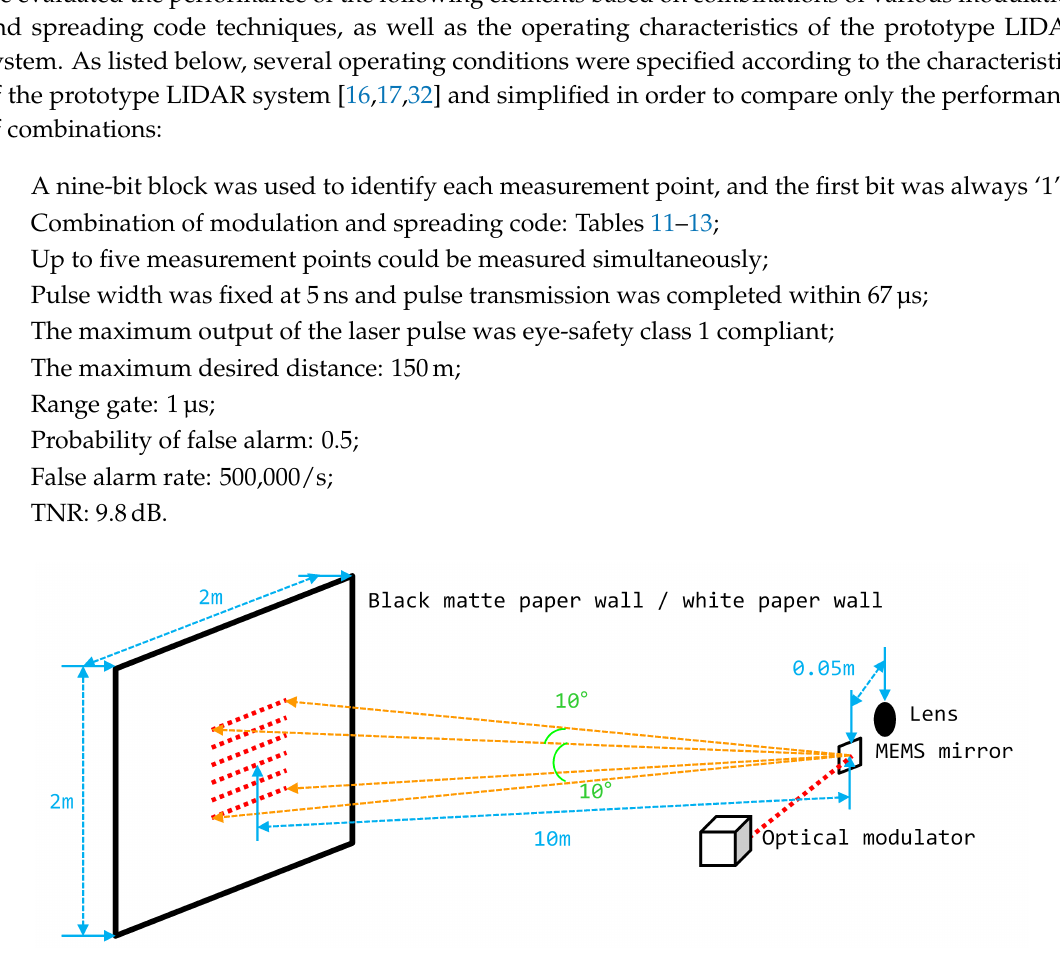
Figure 3. Experimental conditions and optical structure of the prototype LIDAR